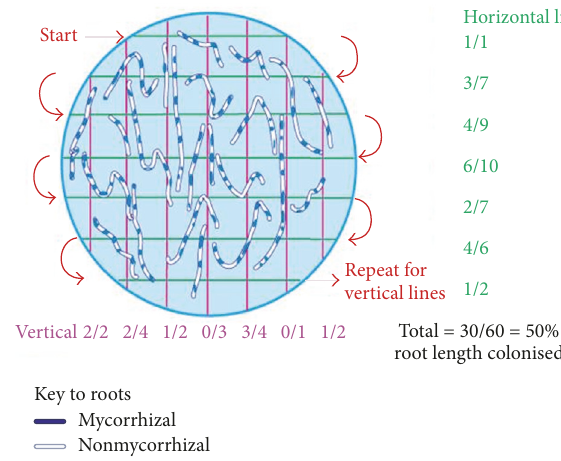
Figure 1: The illustration of how percent root length colonised is determined using the gridline intersect method. Source: Brundrett, [31]. Note . The diagram shows a grid lined petri dish containing root threads. Figure 2: VAM colonisation as influenced by previous cropping systems and N fertilizer application for Lilongwe site. Key . Each error bar represents a standard error of the mean; CP = cowpea; MZ = maize; PP = pigeon pea; 92N = 92kg N ha −1